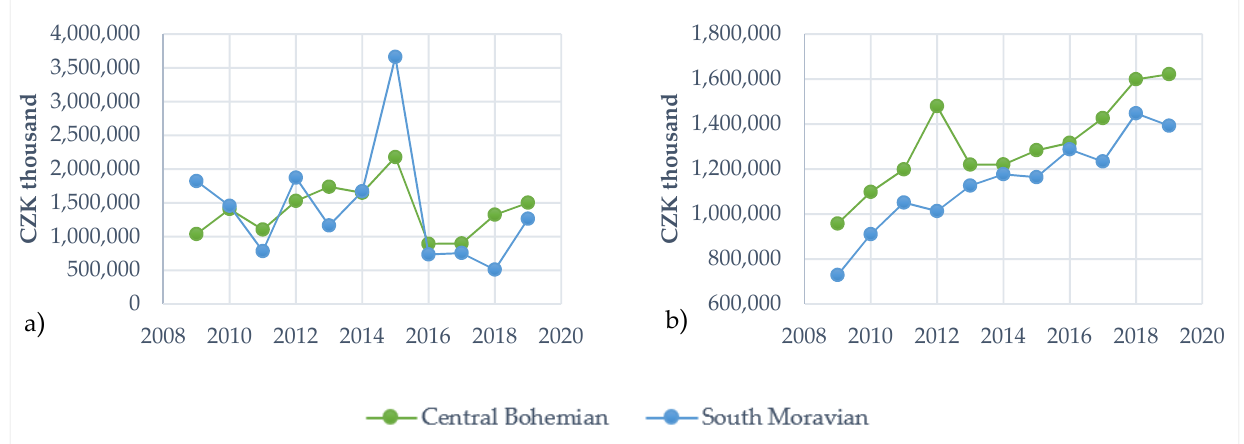
Figure 7. ( a ) Environmental protection investment and ( b ) non-investment expenditure (in CZK thousand) on wastewater management in selected regions.